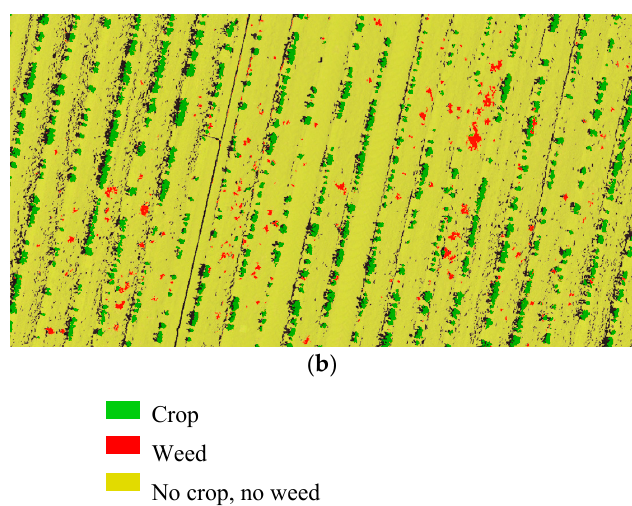
Figure 8. Classified image by applying the auto-trained Random Forest classifier Object Based Image Analysis (RF-OBIA) algorithm to Unmanned Aerial Vehicle (UAV) images at 30 m flight altitude: ( a ) sunflower field; ( b ) cotton field.